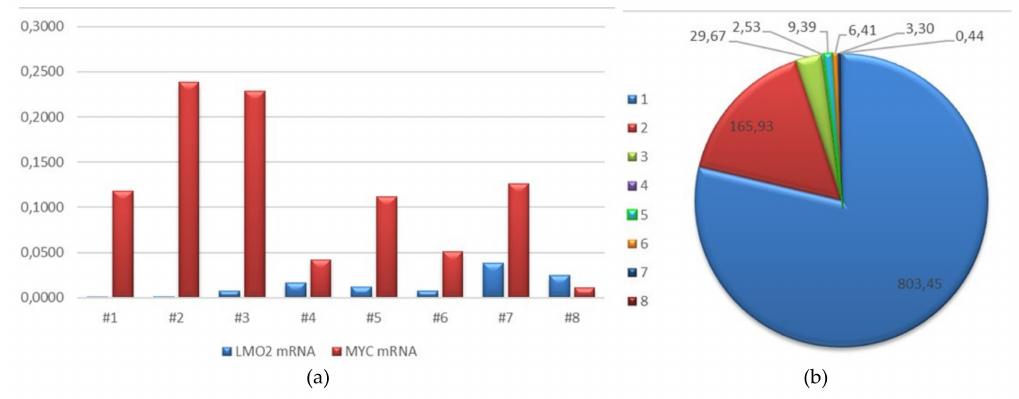
Figure 2. MYC and LMO2 mRNA expression. ( a ) LMO2 and MYC mRNA by quantitative real-time PCR (qPCR) in HGBL-DH / TH (cases #1 to #4), tDLBCL with MYC rearranged, (#5, #6), tDLBCL